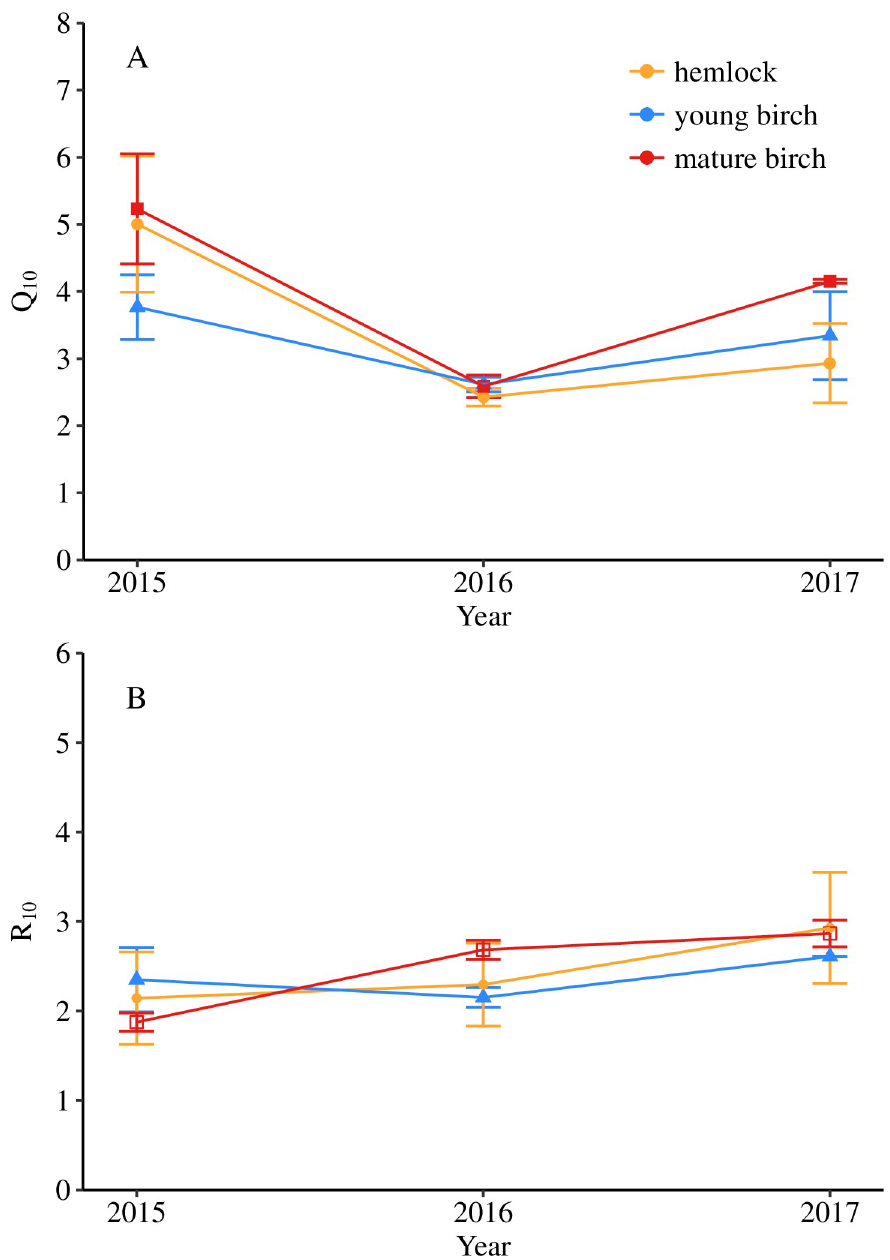
Fig 3. Values of Q 10 and R 10 for each year. Inter-annual variation of Q 10 and R 10 for each forest type over Julian day within 2015, 2016, and 2017. Error bars are ± 1 standard error. Hemlock has yellow circles. Young birch has blue triangles. Mature birch has red